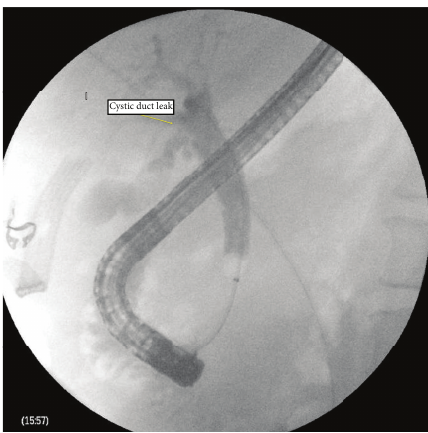
Figure 1: ERCP: bile leak from cystic duct.